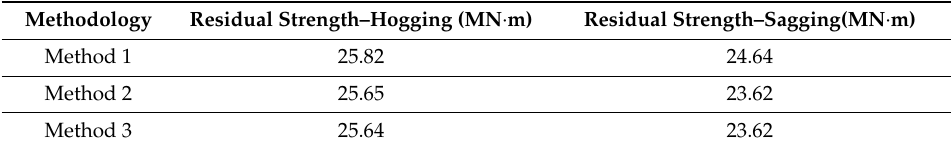
Table 7. Residual strength of CASE